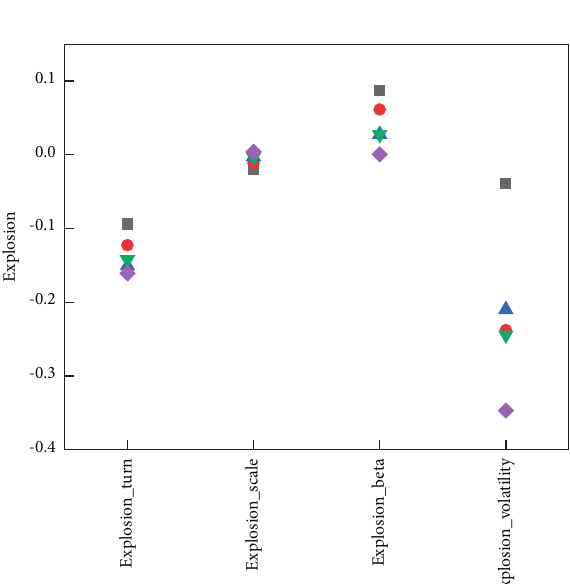
Figure 6: Multi factor fluctuations in different periods.